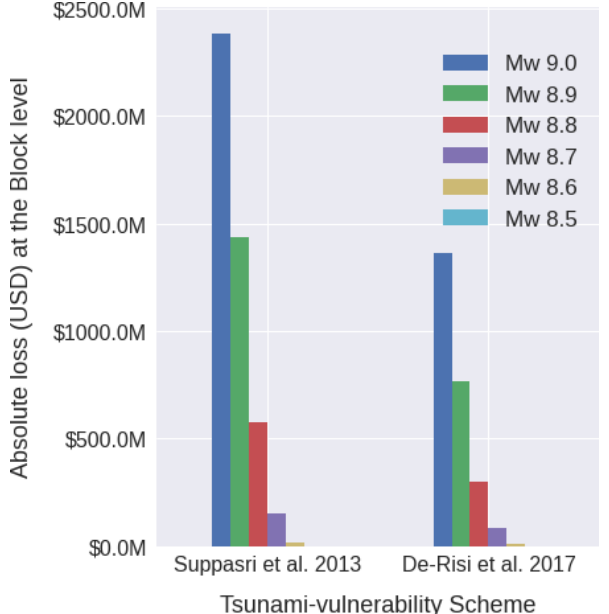
Figure 15. Absolute losses (USD) for six tsunami scenarios for the residential building portfolio of Lima classified in terms of two ref- erence schemes and aggregated at the block-based model.